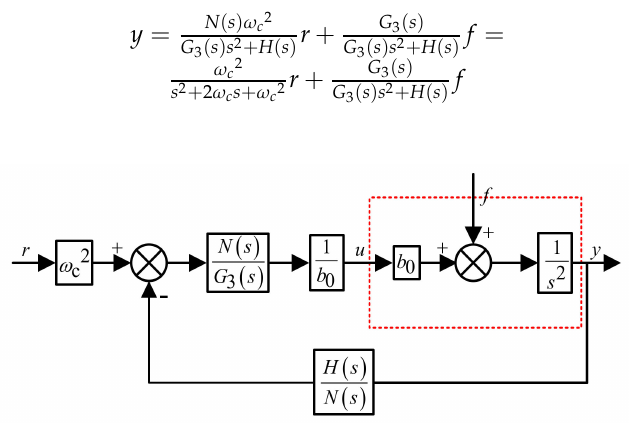
Figure 10. Simplified structure diagram of the improved LADRC.